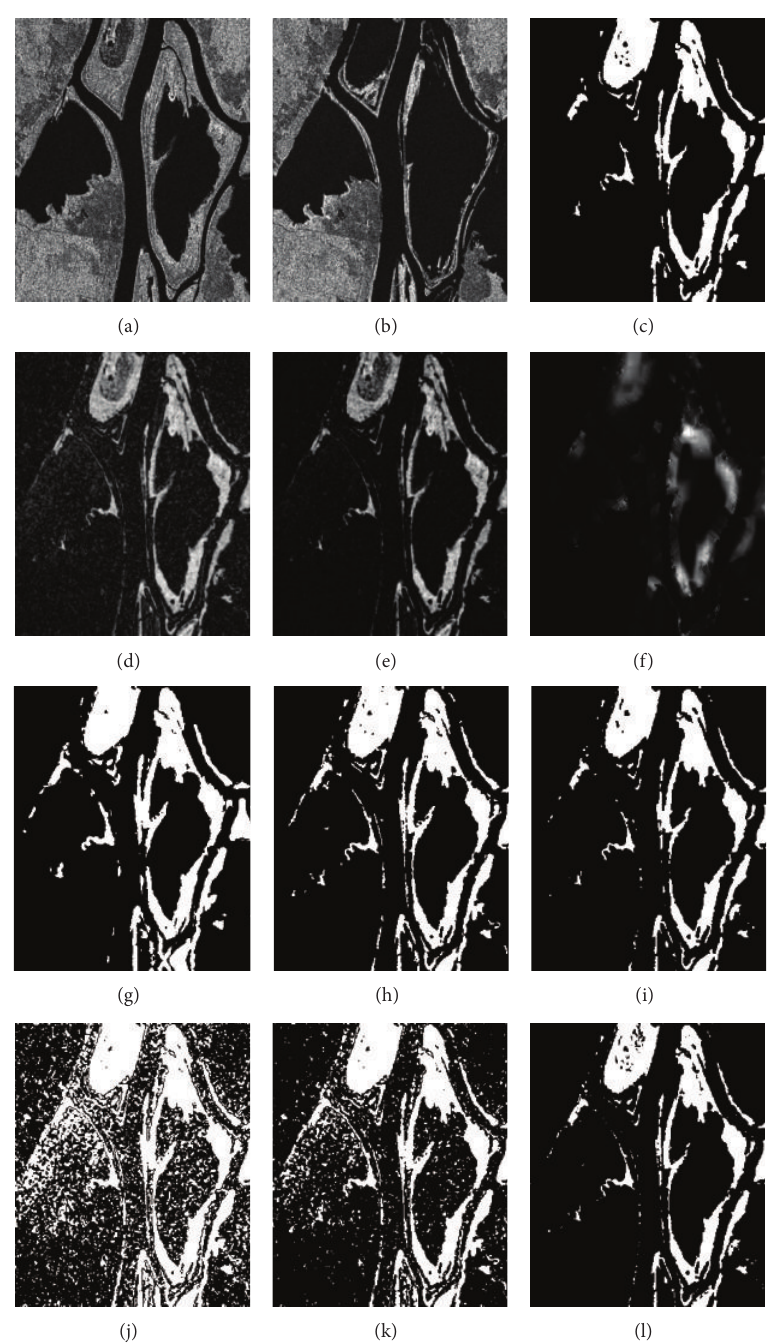
Figure 3: Experimental results on Ottawa dataset. (a) Image acquired in May 1997, (b) image acquired in August 1997, (c) ground truth, (d) LR DI, (e) NLR DI, (f) CKLD DI, (g) change map by CWT-EM, (h) change map by MRF-FCM, (i) change map by MSRM, (j) change map by LR-GKIT, (k) change map by NLR-GKIT, and (l) change map by